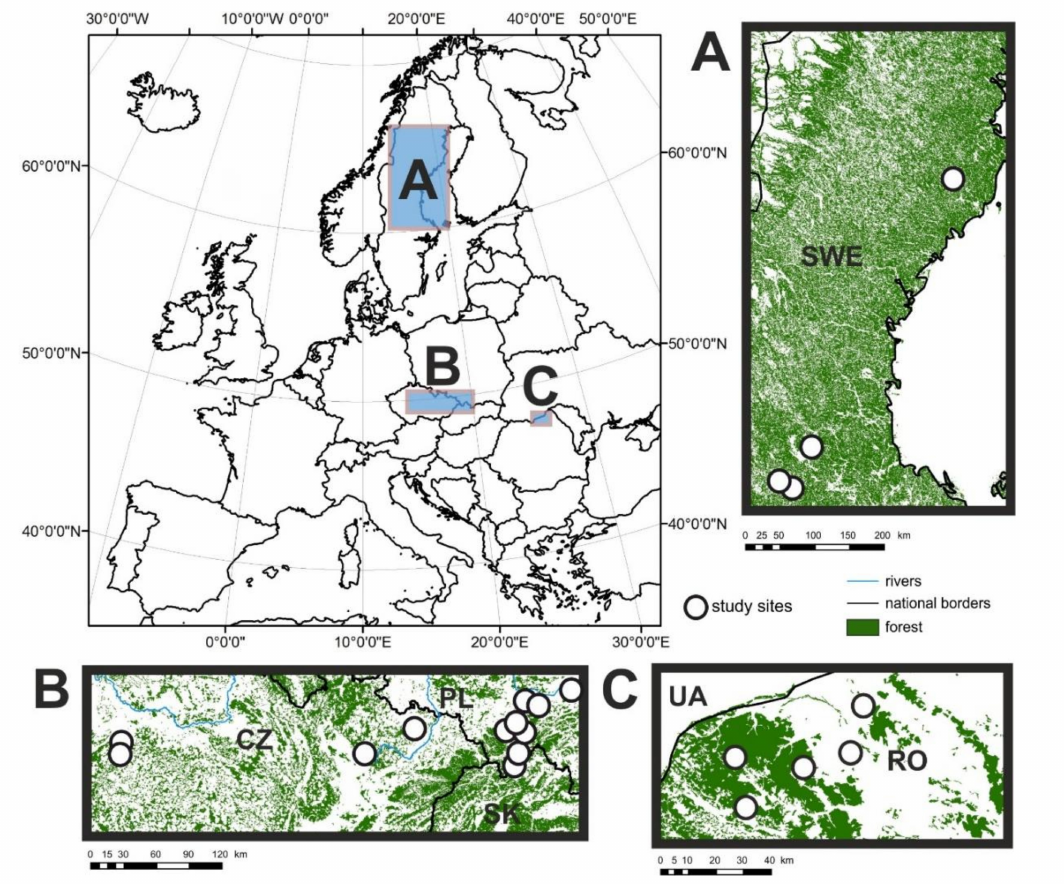
Figure 1. Study sites (circles) in Europe where Ips duplicatus was collected during 2011–2015 in forest areas